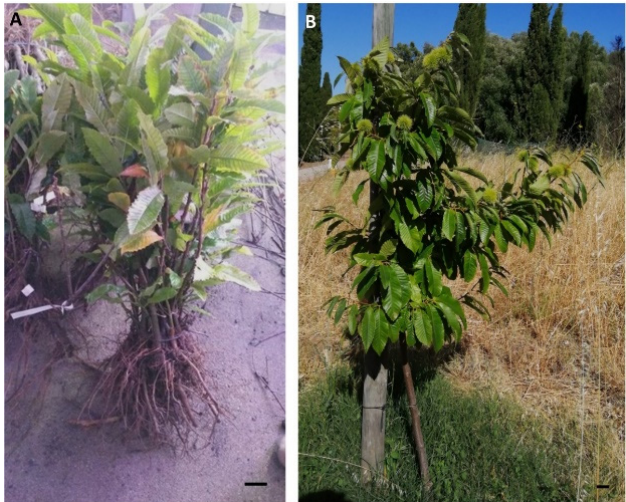
Figure 5. SM904 chestnut hybrids, rooted with adapted MMN liquid medium. ( A ) Plants eight months after acclimatization, with pruned roots before field plantation; ( B ) Plants with 2 years of growth in the field. Bars = 5 cm.